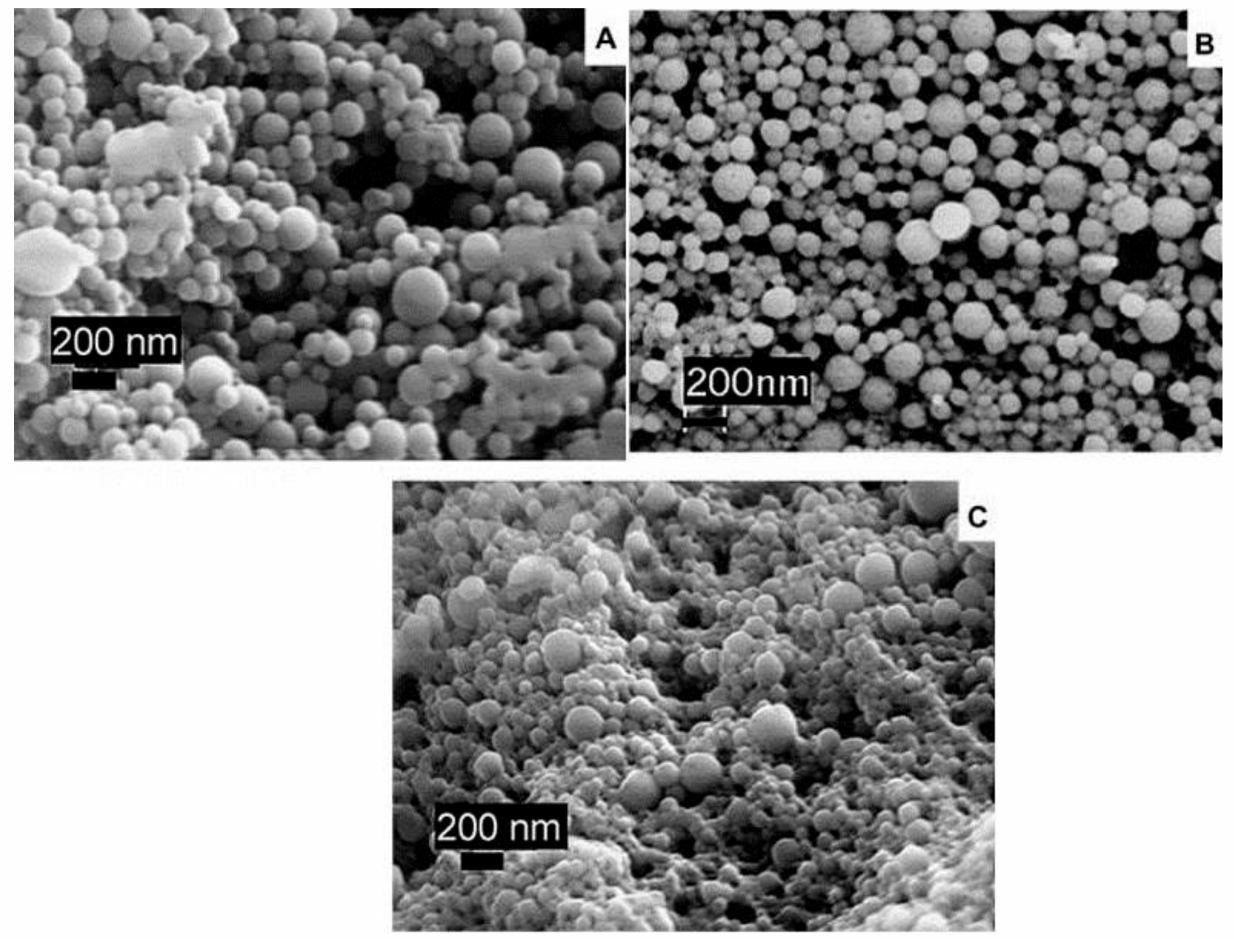
Figure 4. SEM images of zein nanoparticles obtained at three different shear speeds: 5000 rpm ( A ), 10,000 rpm ( B ) and 15,000 rpm ( C ) speeds. Reprinted with permission from ref. [18]. Copyright 2009